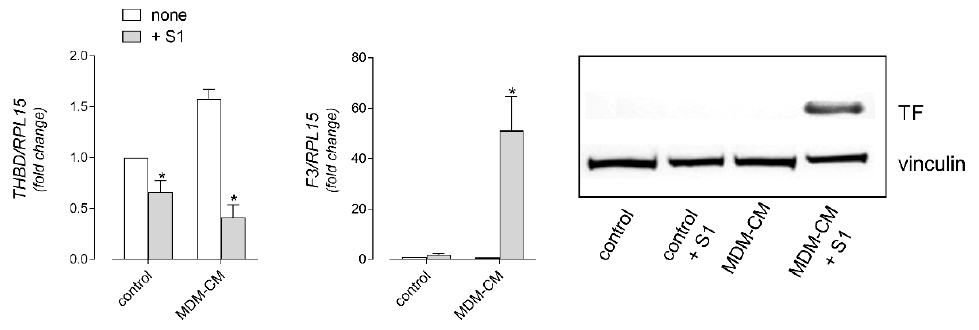
Figure 7. HLMVEC were incubated for 6 h in fresh RPMI1640 (control) or in MDM conditioned medium (MDM-CM), as described in Figure 5. The expression of the indicated genes ( left and middle panels) was then measured by means of RT-qPCR, normalized for that of the housekeeping gene RPL15, and expressed relative to none in control cells (=1); data are means ± SEM of three experiments, each performed in duplicate. * p < 0.05, vs. none in control, with “one-sample t -test”. The amount of the tissue factor (TF) protein was assessed by means of Western Blot analysis, as described in Materials and Methods ( right panel); the representative blot shown was repeated twice and gave comparable